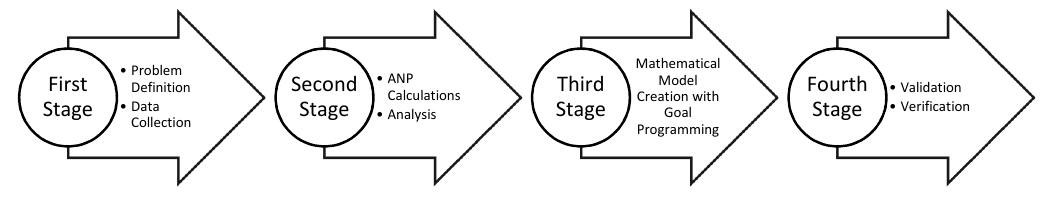
Figure 3. Schematic representation of the study